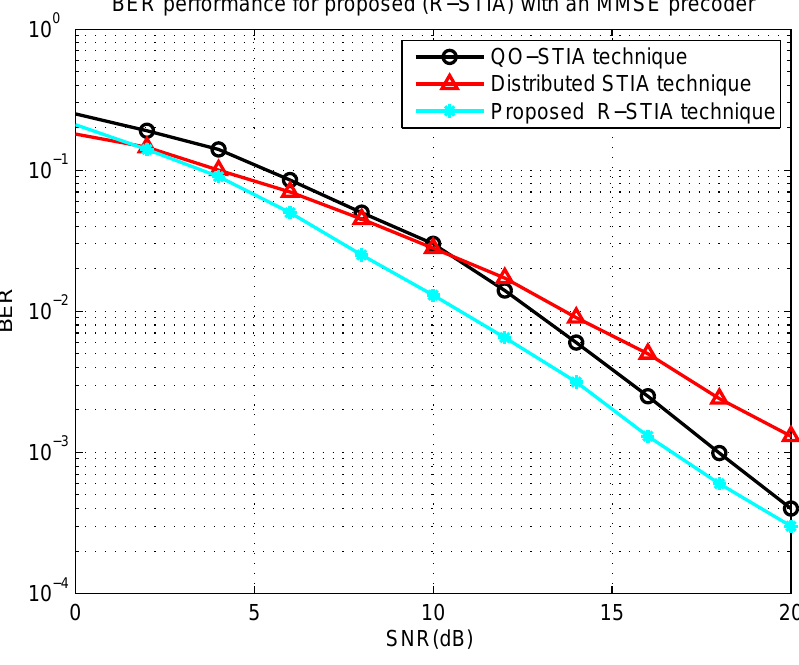
Figure 9. Bit error rate (BER) performance of the proposed relay space-time interference alignment (R-STIA) with an minimum mean square error (MMSE)